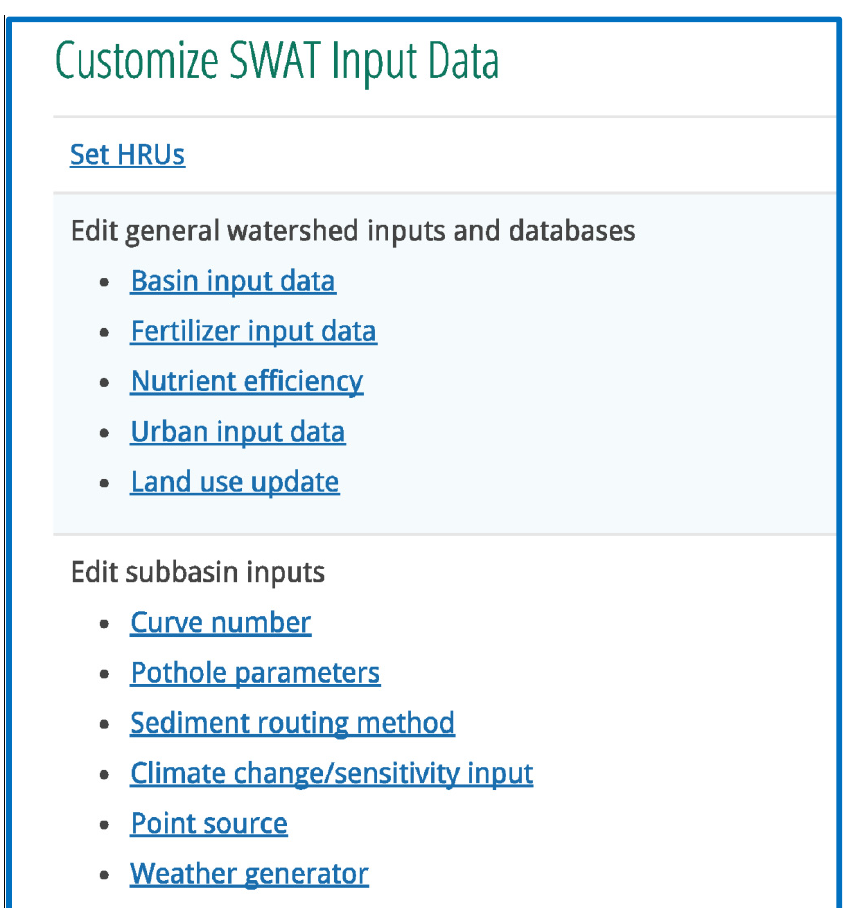
Figure 4. Customization: (i) HRU settings; (ii) basin level settings; and (iii) subbasin level settings.